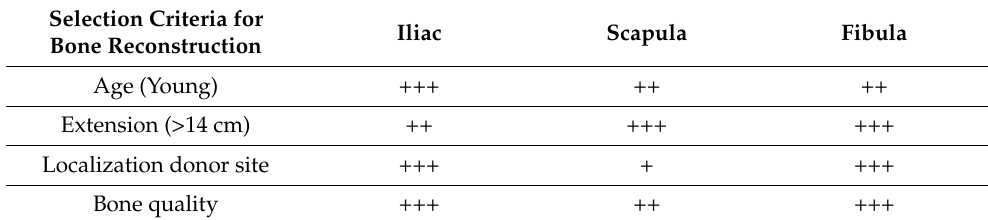
Table 2. Main selection criteria for bone reconstruction. On the right side, three flaps are considered (Iliac, scapula and fibula); +++: First choice, ++: Highly Recommended, +: Recommended. Selection Criteria